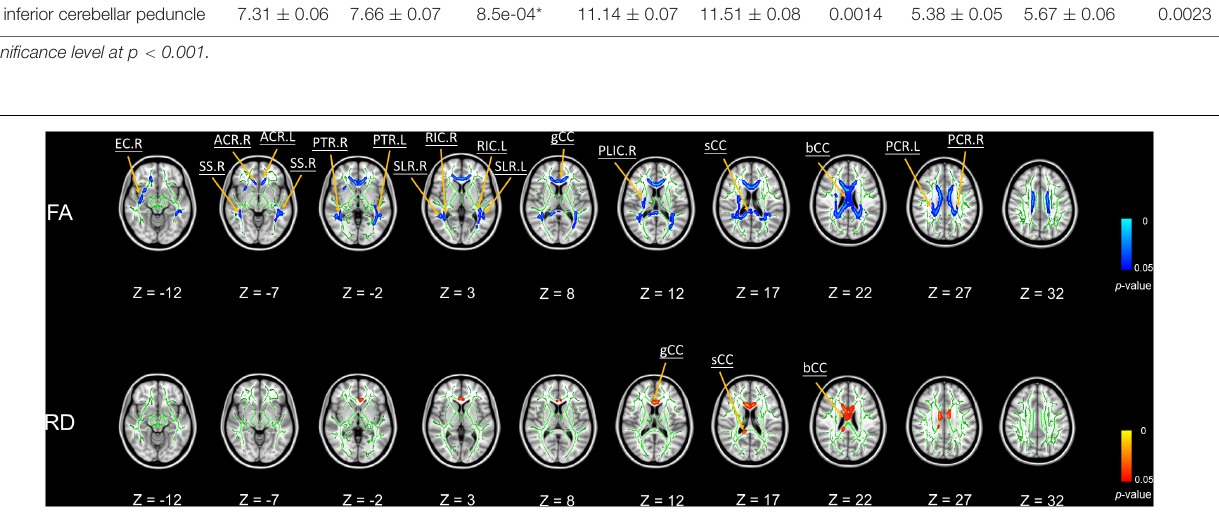
FIGURE 1 | Significant voxel-wise correlations between diffusion metrics of brain white matter (WM) tracts and BDI scores using TBSS (5000 permutations, FWER at p < 0.05). Red color indicates the significant positive correlations between WM tracts and BDI; blue color represents the significant negative correlations.